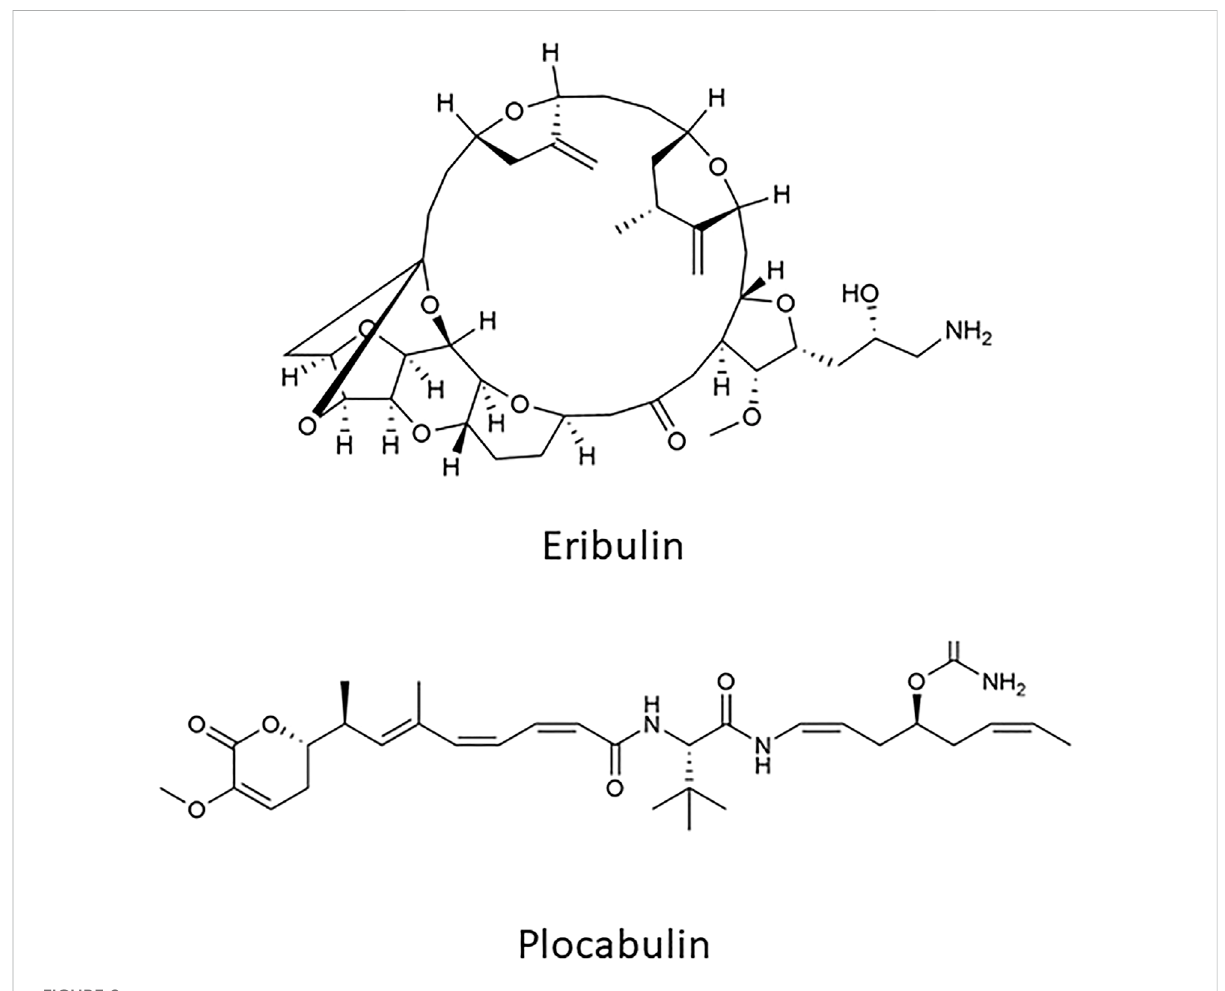
FIGURE 2 Chemical structure of Eribulin and